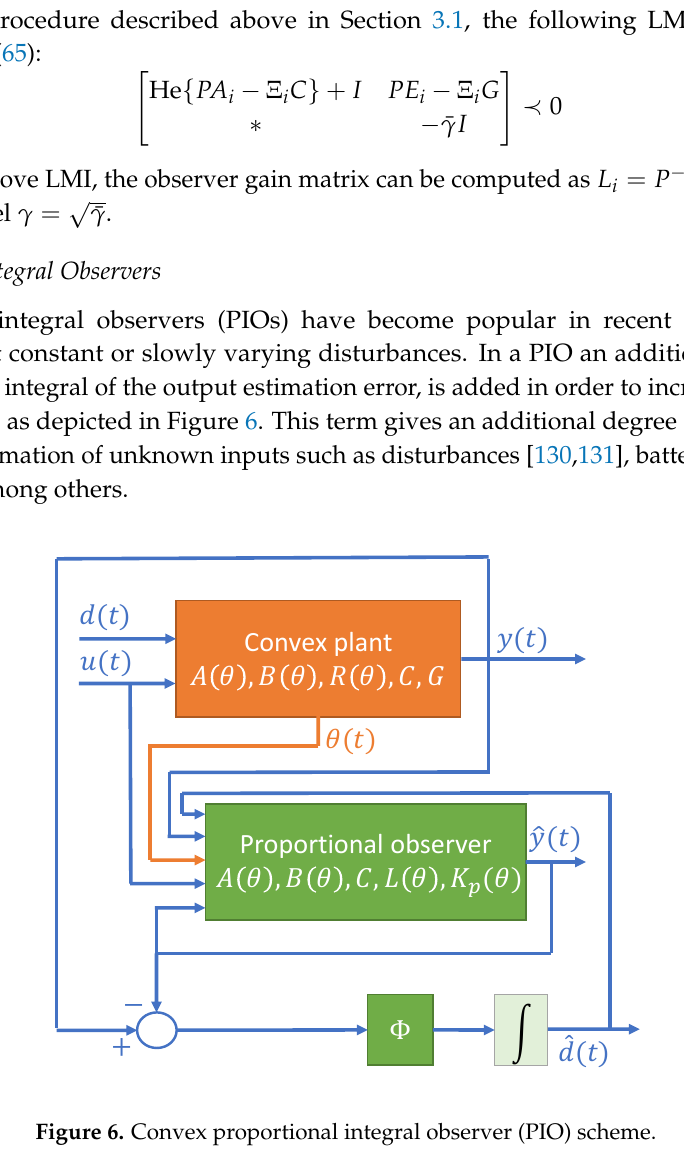
Figure 6. Convex proportional integral observer (PIO)